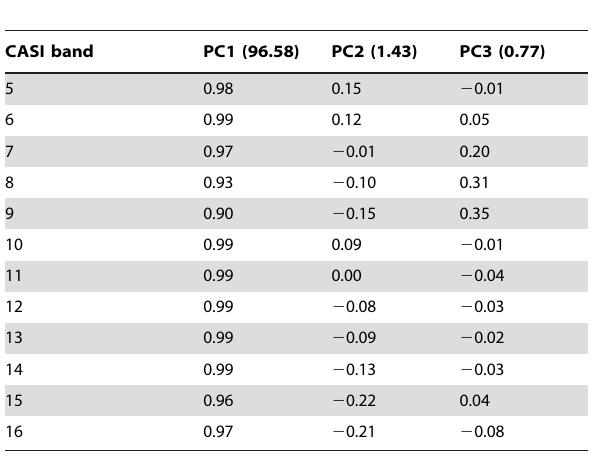
Table 4. Correlations between spectral variability at different spatial